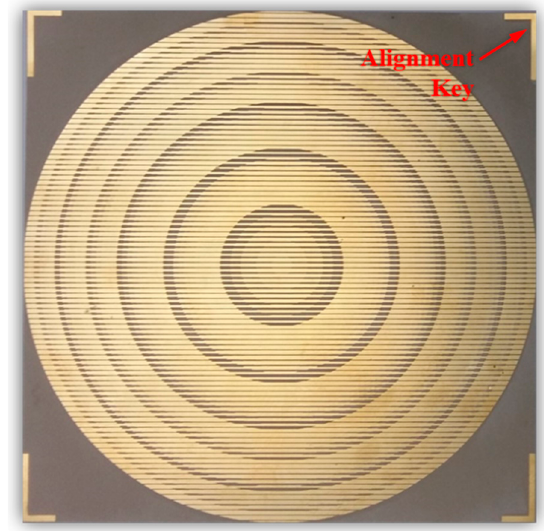
Figure 16. Top view of the fabricated sample of the proposed lens.